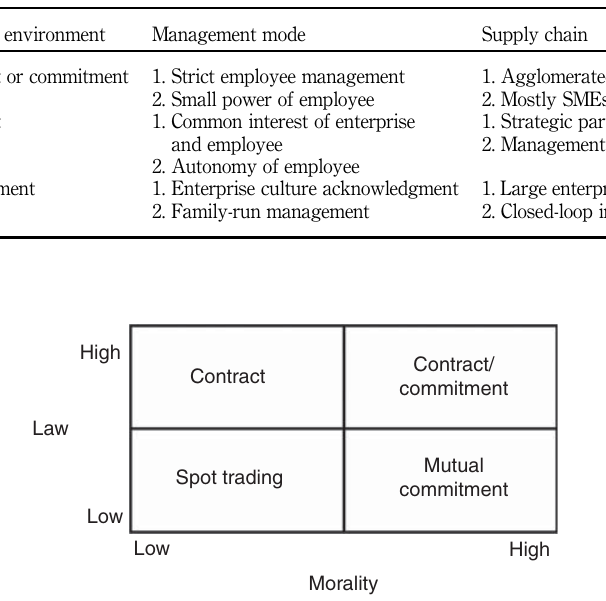
Figure 3. Supply chain model in Japan